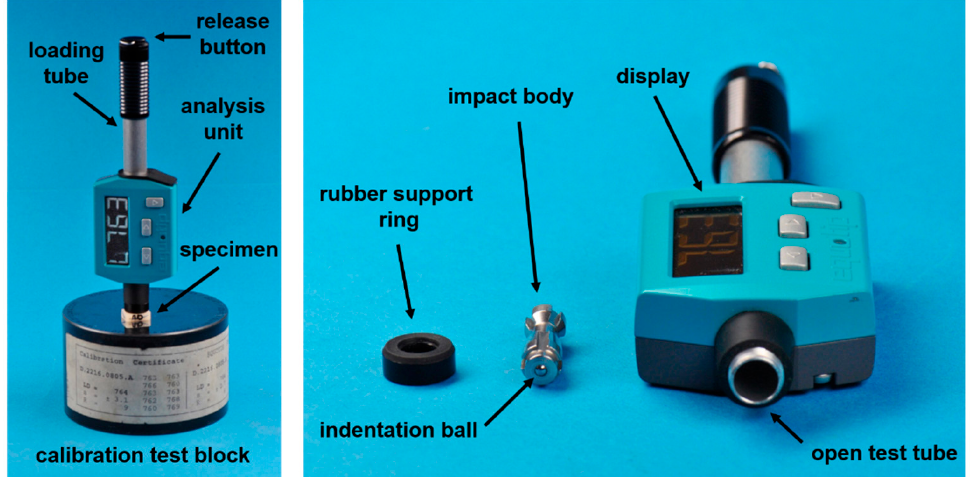
Figure 1. Leeb hardness testing device (Equotip Piccolo 2). Left side: Device placed together with specimen on the calibration test block; right side: disassembled device (from left to right: rubber support ring, impact body with indentation ball; open test tube).